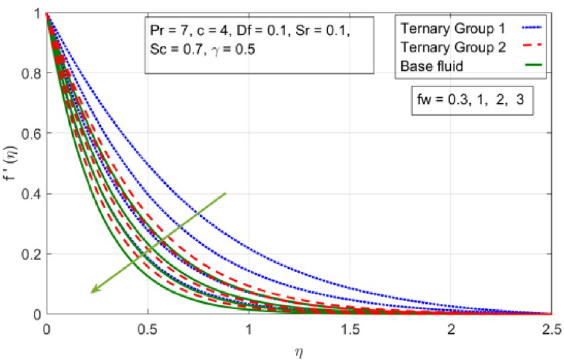
Figure 4. Variation in velocity profile against suction velocity ( f w ) along x-axis.